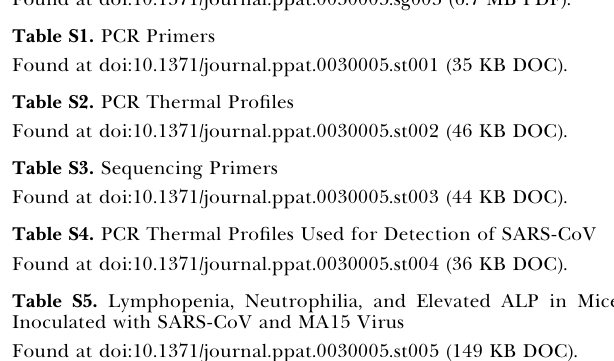
Figure S3. In Situ Hybridization of SARS-CoV RNA in Lungs of BALB/c Mice BALB/c mice were infected with SAR-CoV (Urbani), rMA15 SM , rMA15 ORF1ab , rMA15, or MA15 virus. Lungs were harvested on days 2 and 4 p.i., and in situ hybridization was performed as described in Materials and Methods. No specific signal was observed with a control